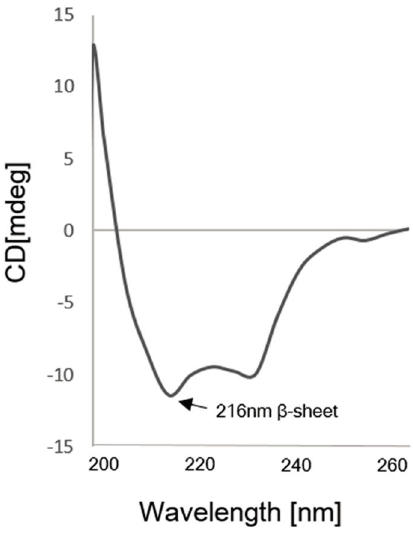
Figure 5. Far-UV circular dichroism (CD) spectra for the refolded scFv. The scFv fragment (0.5 μ g/mL) dissolved in 50 mM Tris pH 7.5, 100 mM NaCl and 5% glycerol was analyzed at room